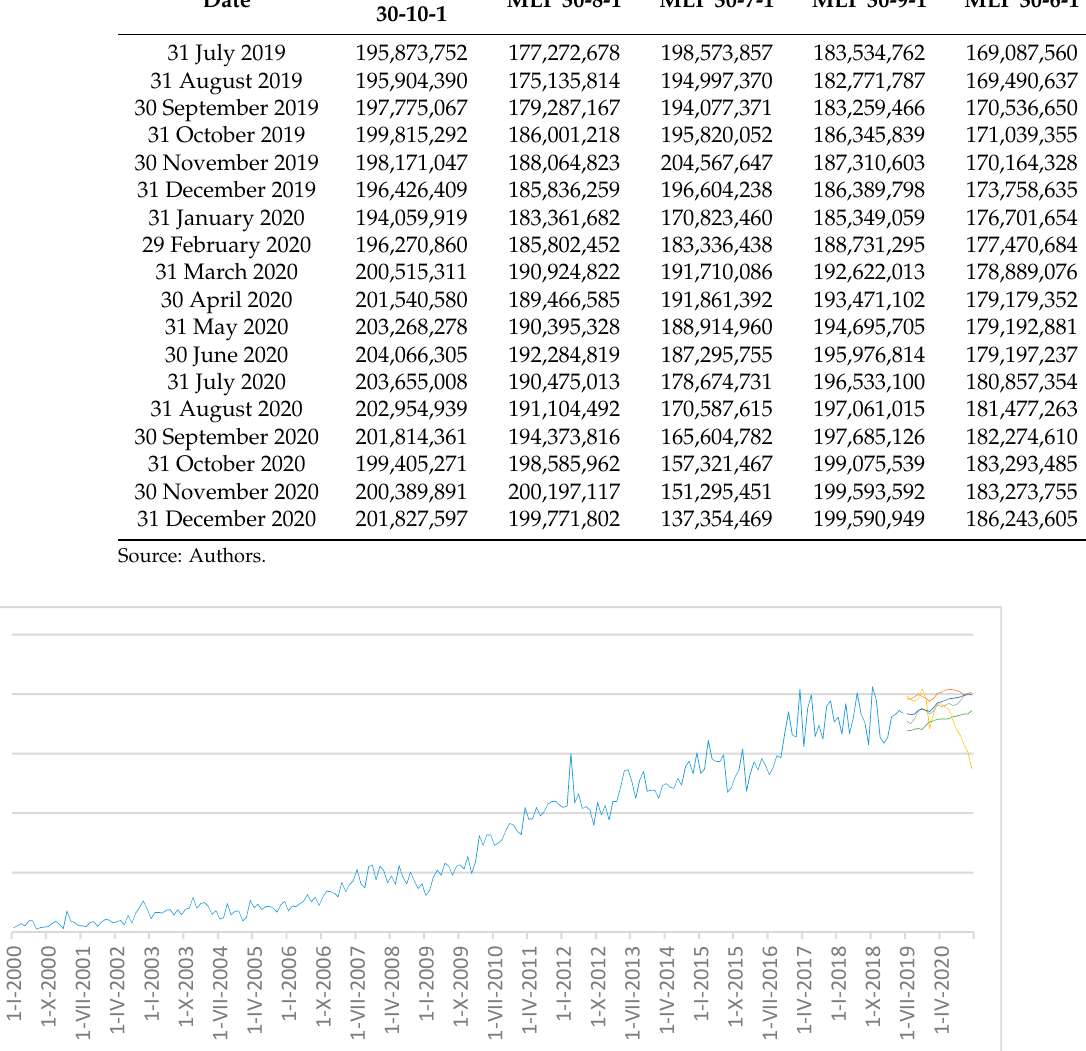
15 of 28 Figure 6. Equalized time series for retained networks (Experiment 3) . Source: Authors. As was the case in the previous two experiments, the focus is on the predictive ability of the neural networks with regard to the development of the variable. The data for the predicted development of the CR’s exports to the PRC from July 2019 to December 2020